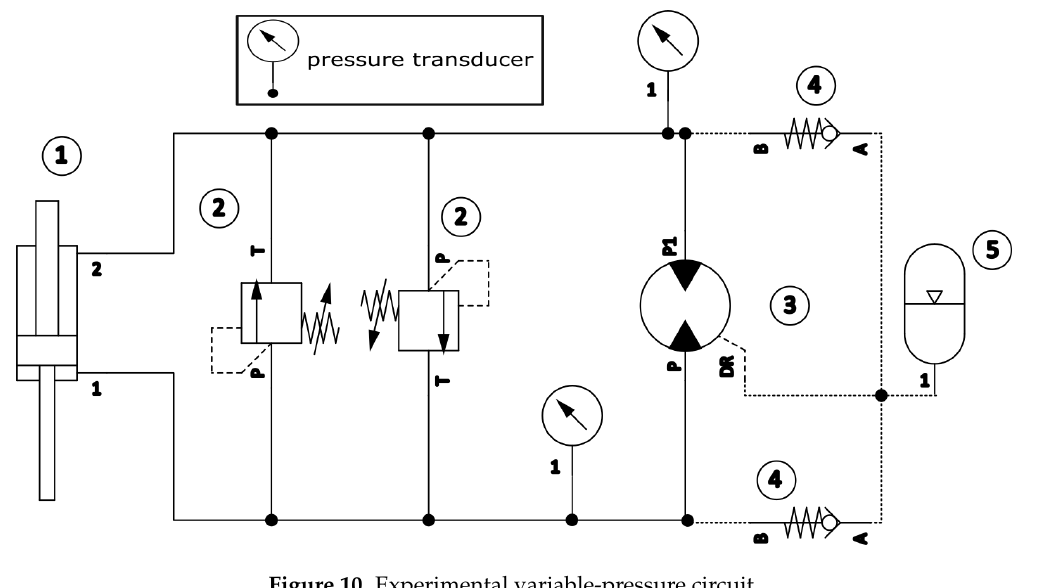
Figure 10. Experimental variable-pressure circuit. Table 2. Variable pressure test rig components.